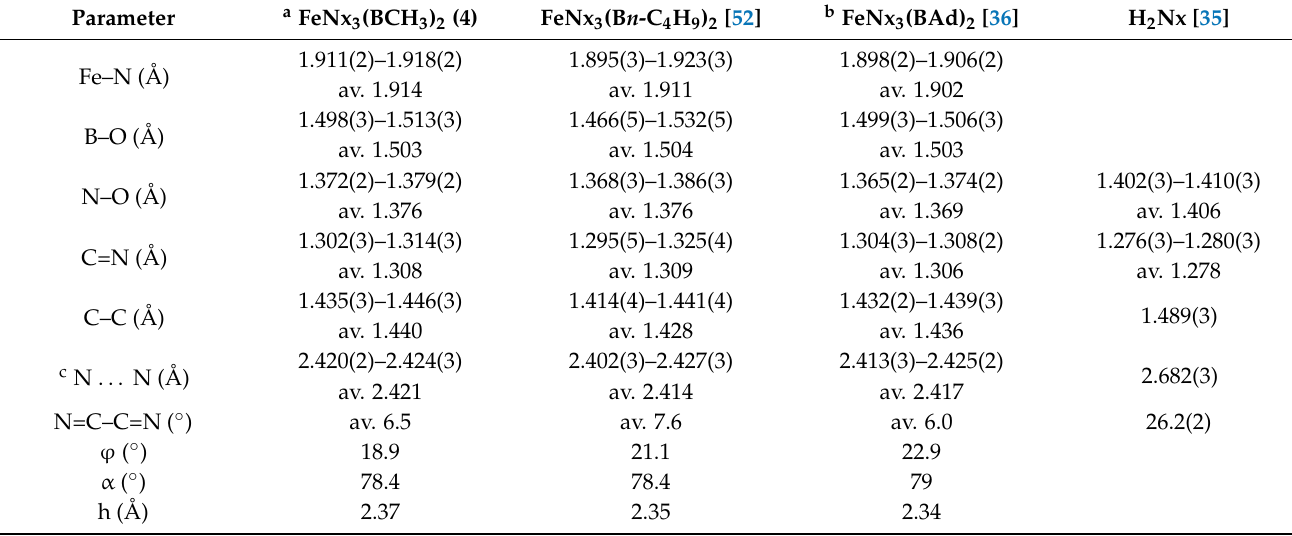
Table 3. Main geometrical parameters of the alkylboron-capped iron(II) tris-nioximate molecules and those for the initial α -dioxime